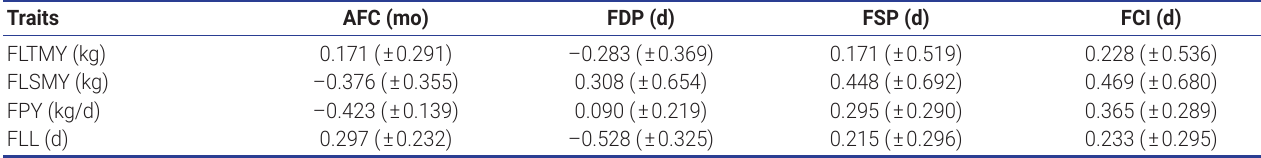
Table 3. Genetic correlation between first lactation production and reproduction traits in Murrah buffaloes Traits